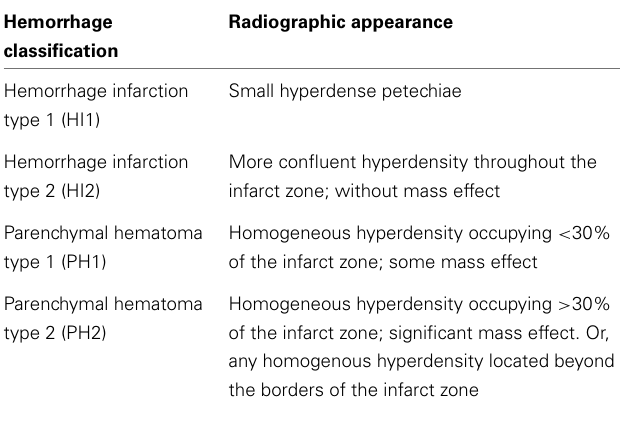
Table 1 | Radiographic classification of the spectrum of hemorrhagic transformation, based on criteria proposed by Fiorelli et al.